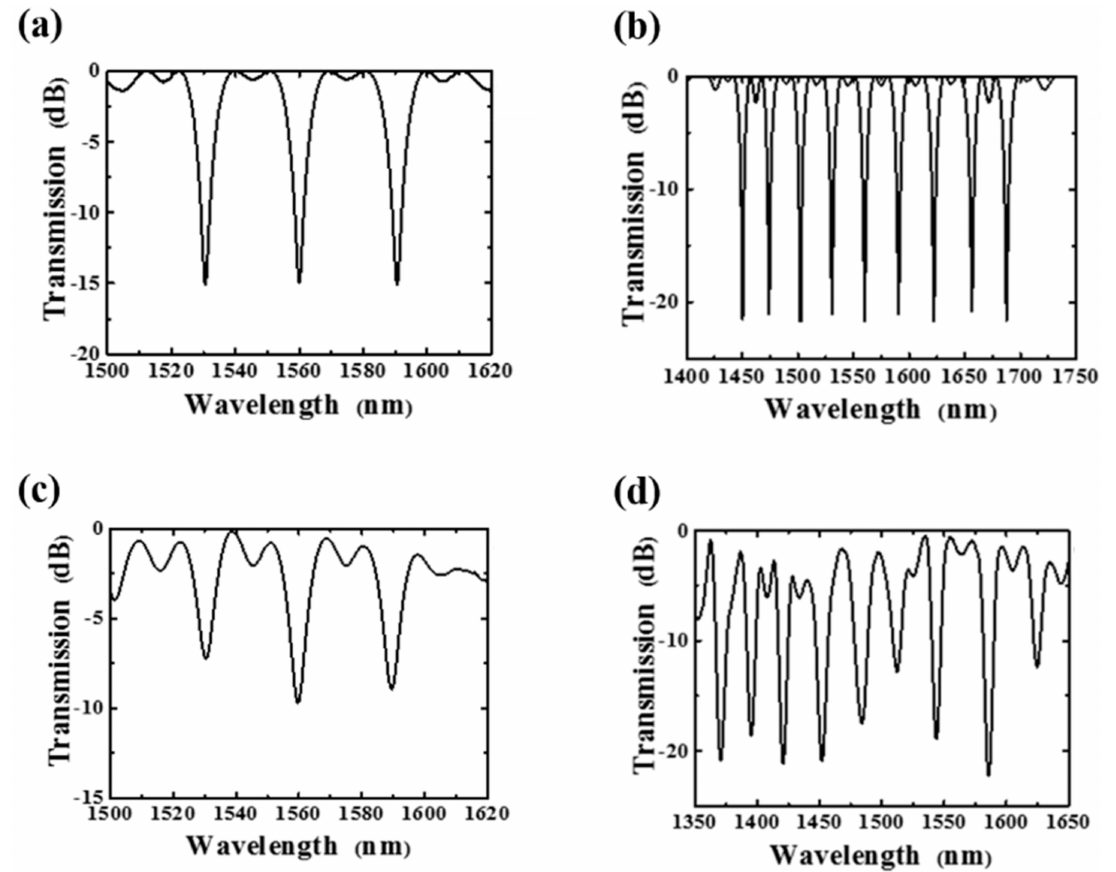
Figure 34. Design and experimental results for 3- and 9-channel phase-only sampled HLPG. Design results for ( a ) 3-channel and ( b ) 9-channel HLPGs. Experimental results for ( c ) 3-channel and ( d ) 9-channel HLPGs. Adapted with permission from ref. [175]. © The Optical Society.